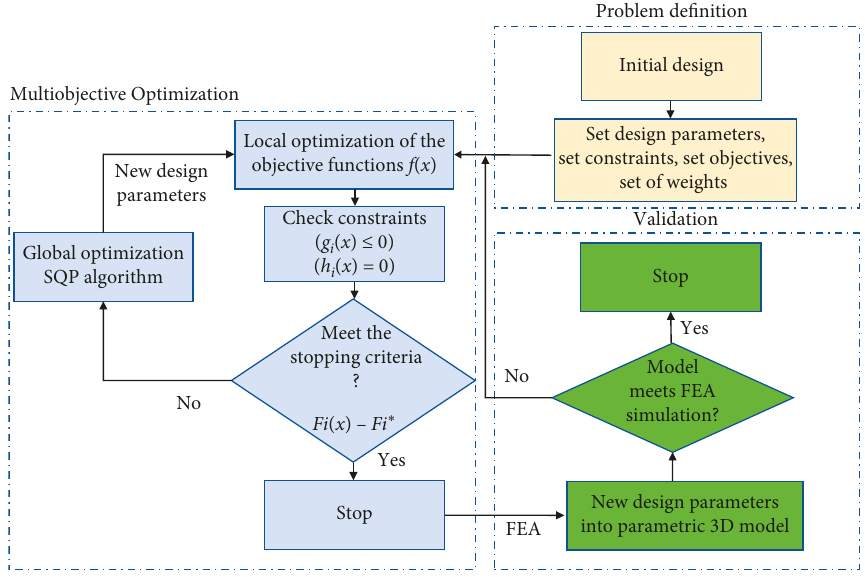
Figure 7: Proposed optimization methodology. Table 1: Proposed model structural parameter values and optimal values given by the optimization in MATLAB ® .